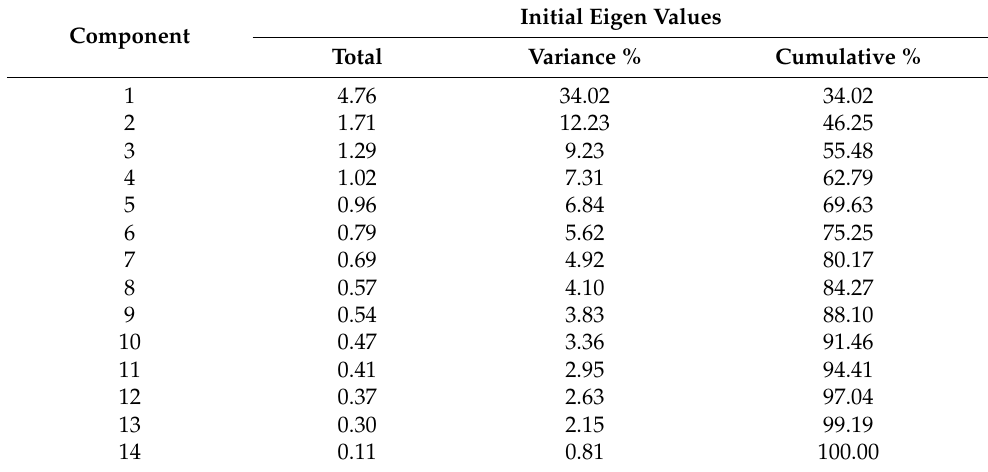
Table 4. Total variance explained in soil respiration, plant functional traits, and environmental factors.